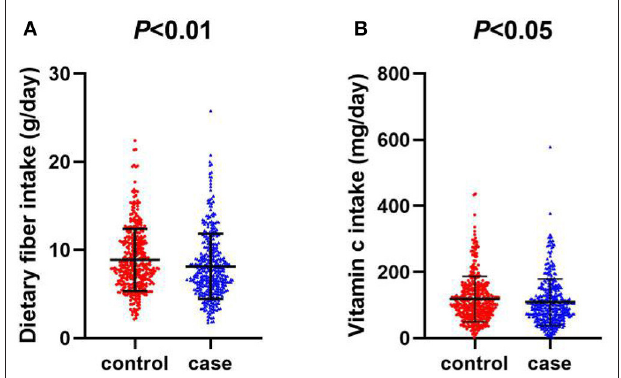
FIGURE 1 | (A) Scatter diagram of daily intake of dietary fiber between oral cancer and control group. (B) Scatter diagram of daily intake of vitamin C between oral cancer and control group.